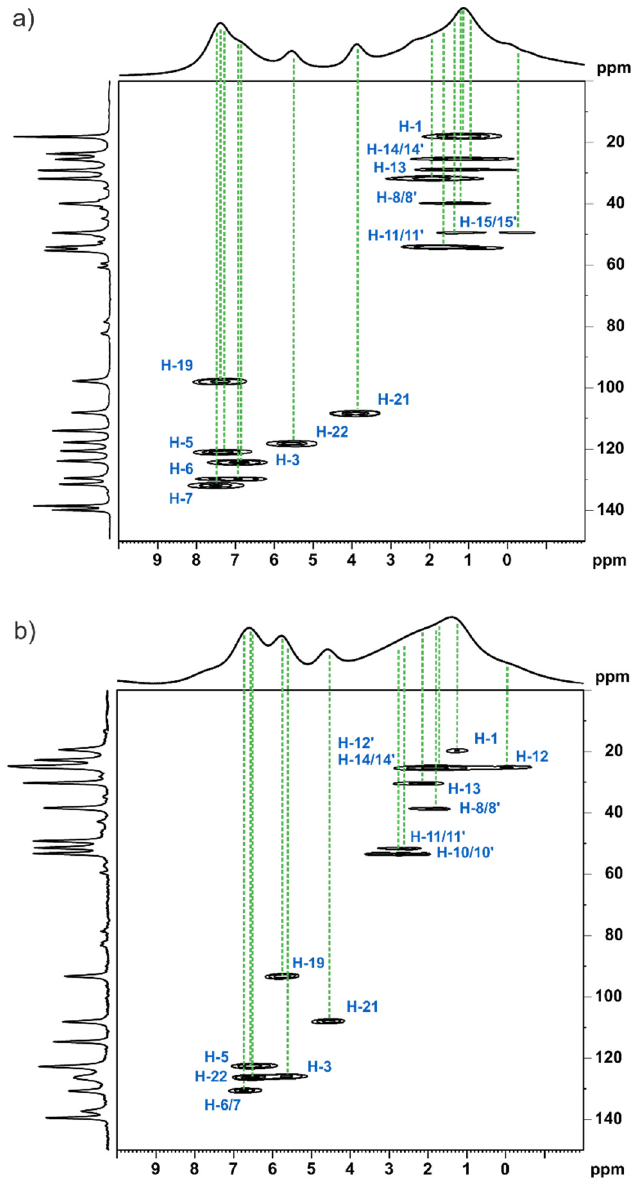
Figure 11. 13 C– 1 H invHETCOR MAS NMR spectra of MBS ( a ) and MBS HCl ( b ) recorded at 90 °C with a spinning rate of 60 kHz at a 1 H Larmor frequency of 600.1 MHz with a second 13 C → 1 H CP contact time of 100 μ s. A one-pulse 1 H MAS spectrum is shown at the top and 13 C CP MAS in the left.